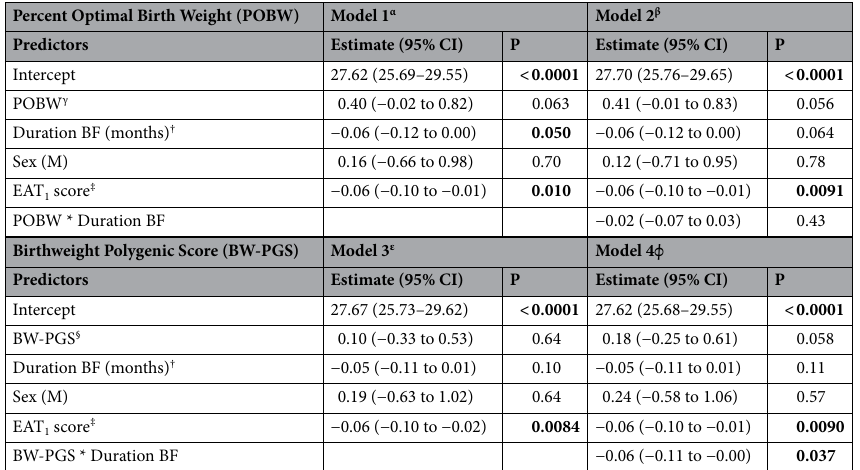
Table 2. Association analyses for body mass index (kg/m 2 ). γ POBW = Percent Optimal Birth Weight (standardised); † Duration of BF = Duration of any breastfeeding (mean-centred); ‡ EAT 1 score = quality of early life nutrition in first year of life; § BW-PGS = birth weight polygenic score (standardised); δ adjustment for population stratification; α Model 1 examines the effect of duration of breastfeeding adjusting for POBW, sex and EAT 1 score; β Model 2 examines the effect modification of duration of breastfeeding by POBW adjusting for sex and EAT 1 score; ε Model 3 examines the effect of duration of breastfeeding adjusting for BW-PGS, sex, EAT 1 score and the first two principal components [PCs] (estimates not presented); effect modification of duration of breastfeeding by BW-PGS adjusting for sex, EAT 1 score and the first two principal components [PCs] (estimates not